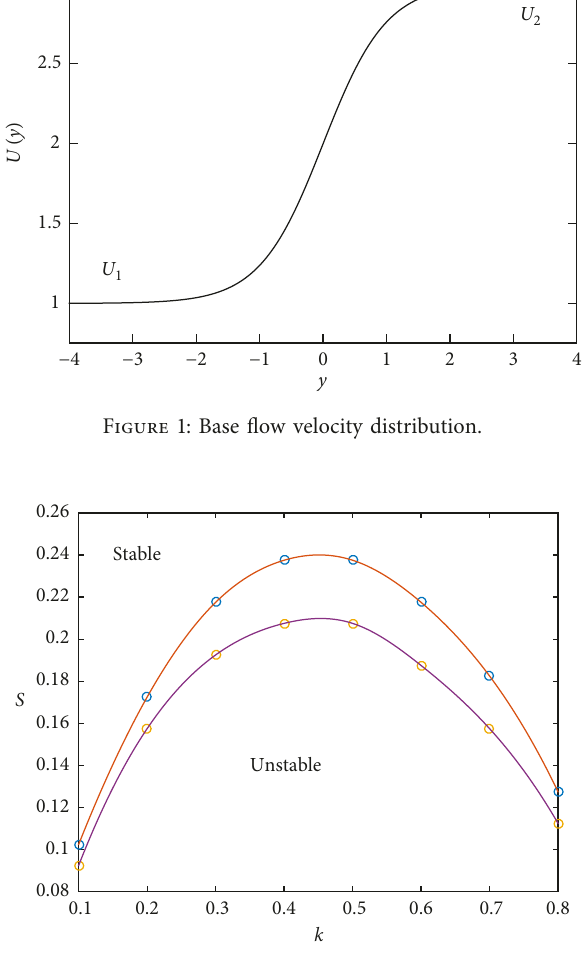
Figure 2: Marginal stability curves for the cases β � 0 . 3 , α � 1 (bottom curve) and α � 20 (top